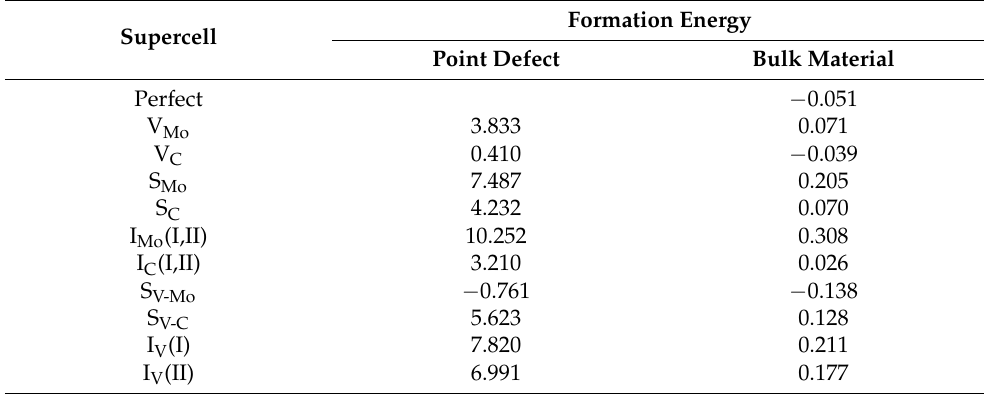
Table 1. Formation energy (eV) of point defects and bulk material with defects for Mo 2 C. Supercell